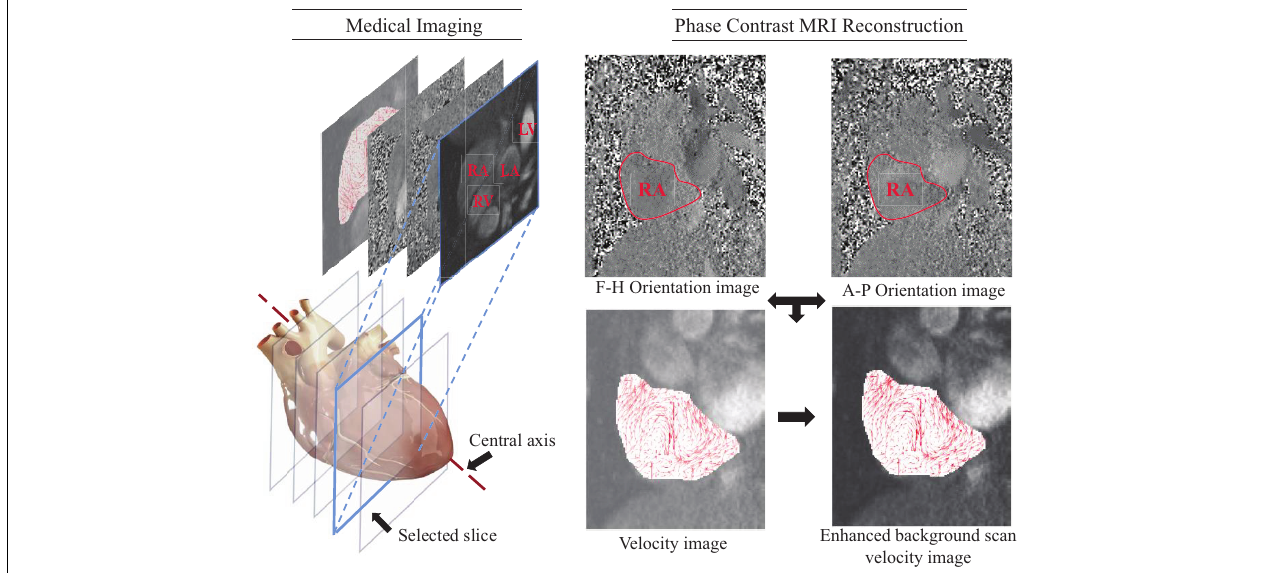
FIGURE 1 | A representation of the MRI scan images through the heart, and PC-MRI based velocity images in a cardiac chamber. The PC-MRI pertains to the Foot-Head (F-H) and the Anterior-Posterior (A-P) orientations, respectively, the intensity of the whose pixels indicates the magnitude of the velocity component in the specified orientation. Combining two orthogonal velocity-encoded images can yield a velocity flow